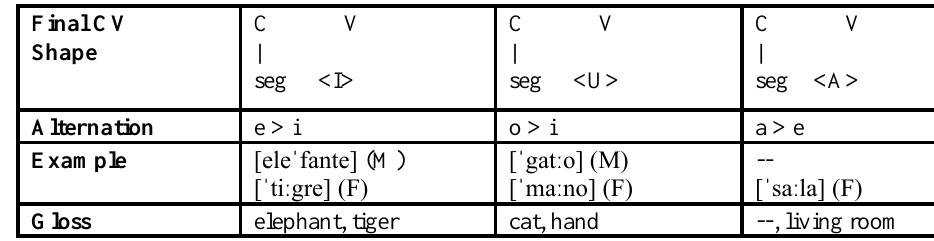
Table 1. C filled, V associated with floating |I|, |U|, or |A|